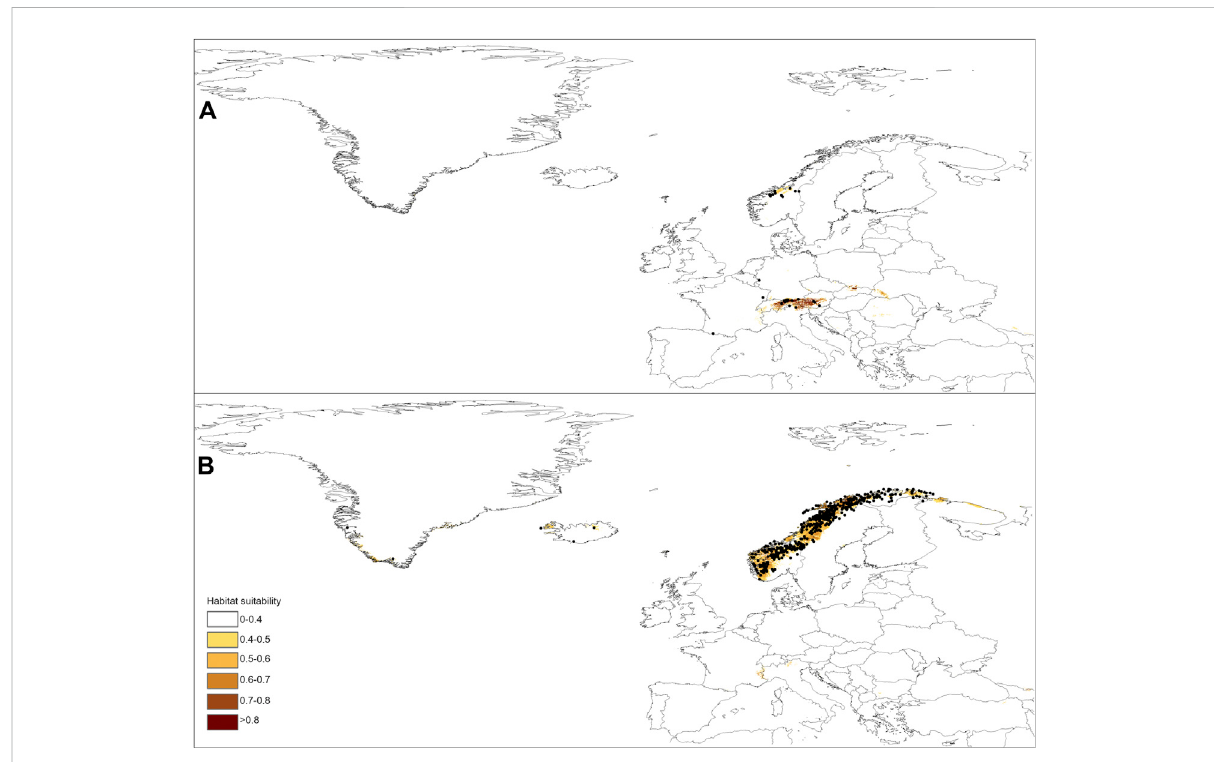
FIGURE 3 Currentdistribution ofsuitablenichesfor P. albida ssp. albida (A) and P.albida ssp. straminea (B) alongwith thelocalitiesincludedinthemodels (marked by black